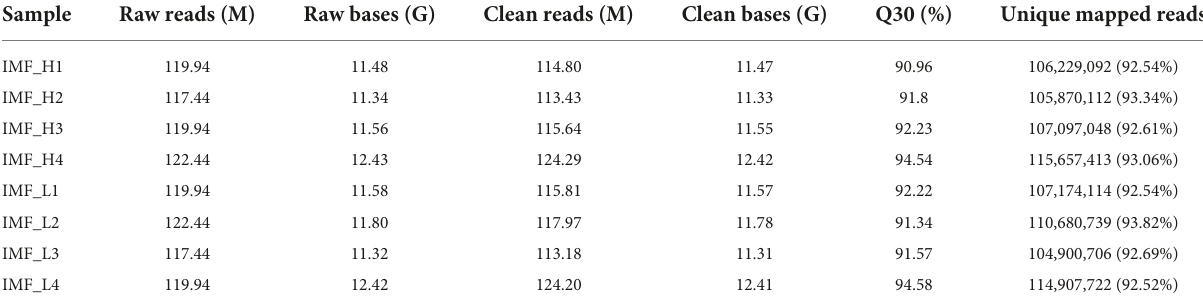
TABLE 3 Summary of the RNA-seq